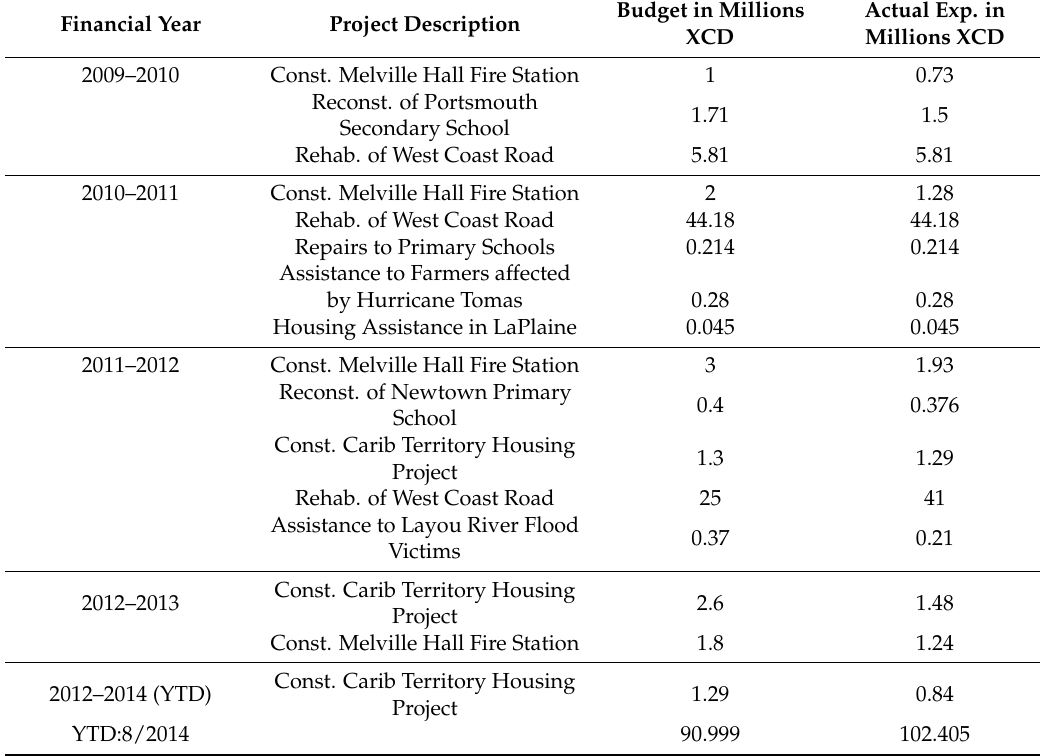
Table 2. PRC Grants to Dominica with Project